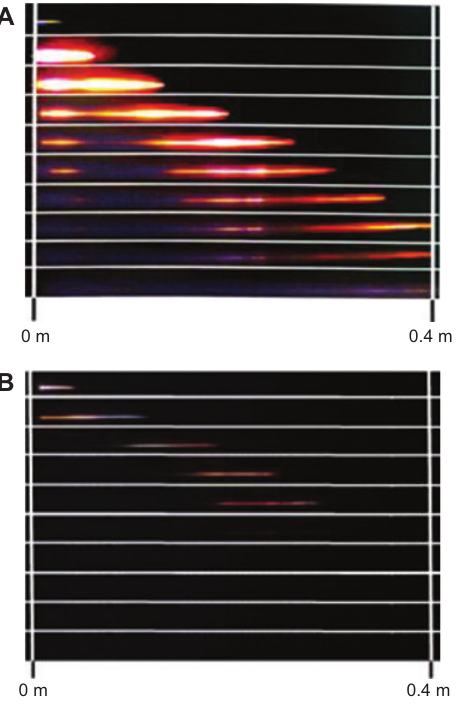
Figure 4 (A) Transmission of a C